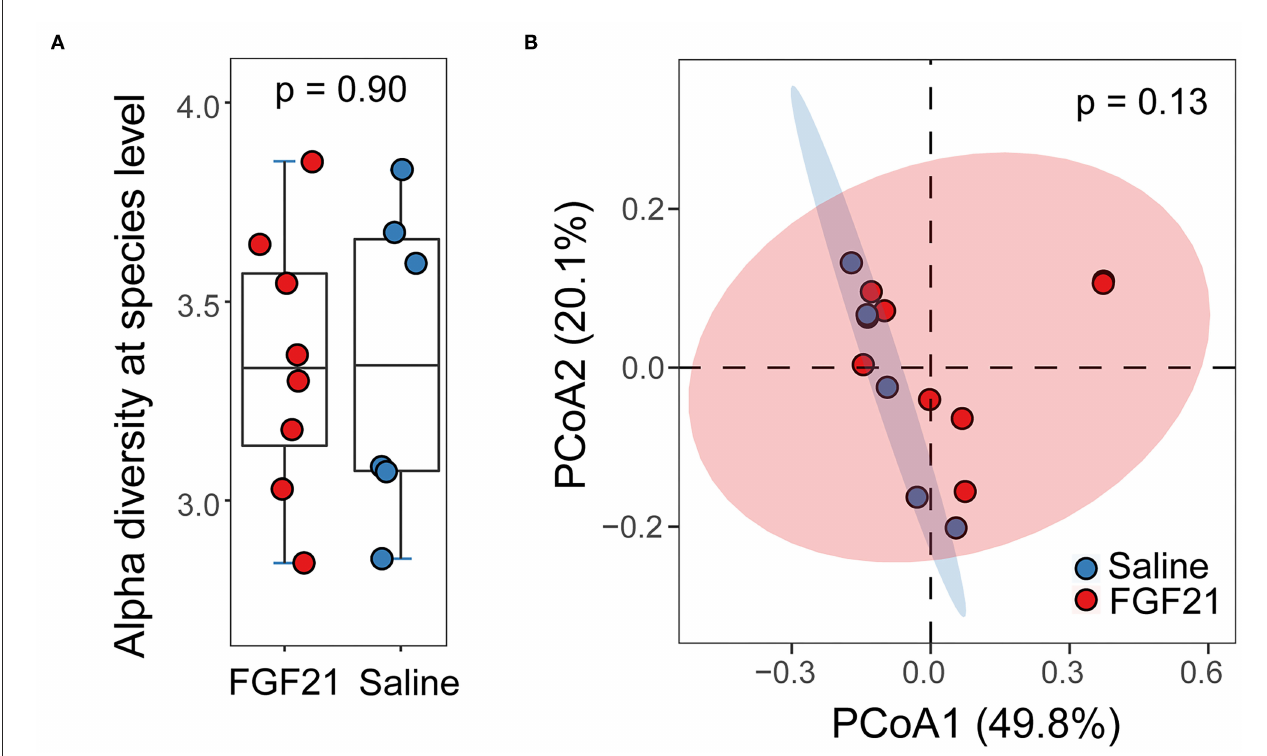
FIGURE5 FGF21 treatment did not alter the feline gut microbiome. (A) Boxplots of alpha diversity in cat gut microbiome of FGF21-treated (red) and saline-treated (blue) groups at the species level measured by the Shannon index. (B) The Principal Coordinates Analysis (PCoA) plots of beta diversity between FGF21-treated (red) and saline-treated (blue) groups using Bray-Curtis distance. Statistical significance was assessed using permutational multivariate analysis of variance (PERMANOVA).